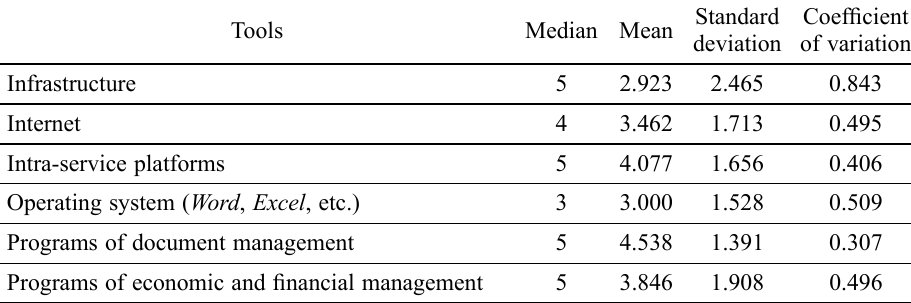
Table 3. Technological tools to provide high-quality